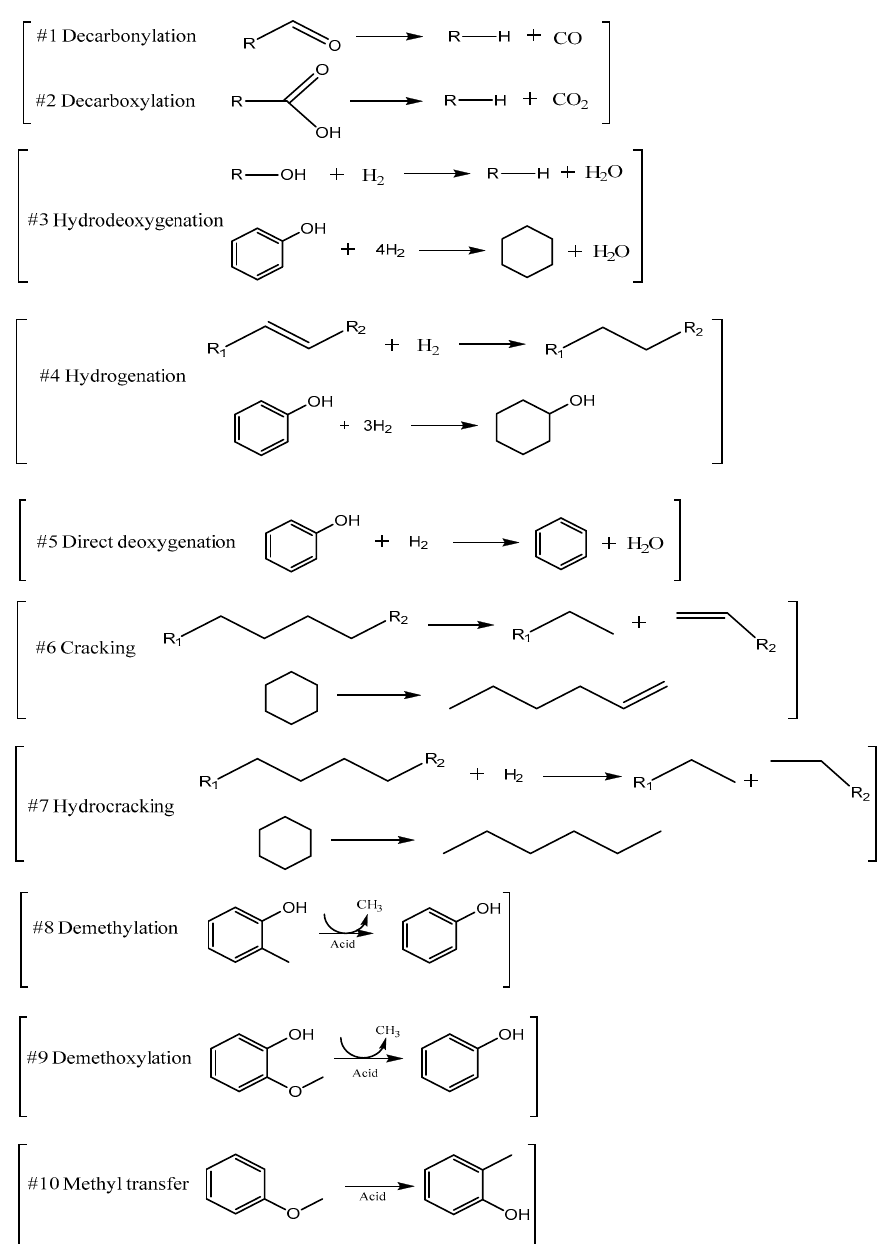
Figure 5. A comprehensive reaction network in bio-oil upgrading. Reprinted from reference [43]. Table 5. An overview of the advantages and disadvantages of various upgrading methods [24,44,45].